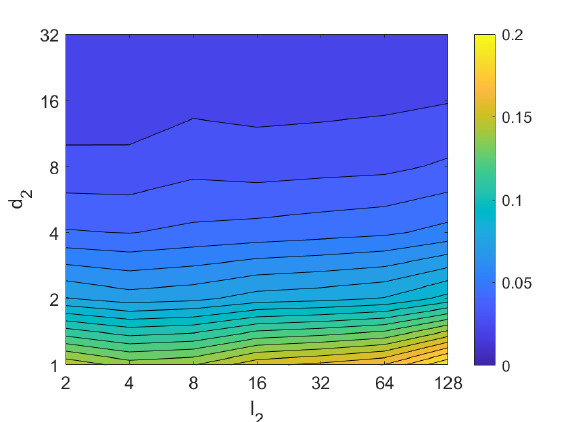
Figure 37. Gist orientation estimation. Average computation time (s).